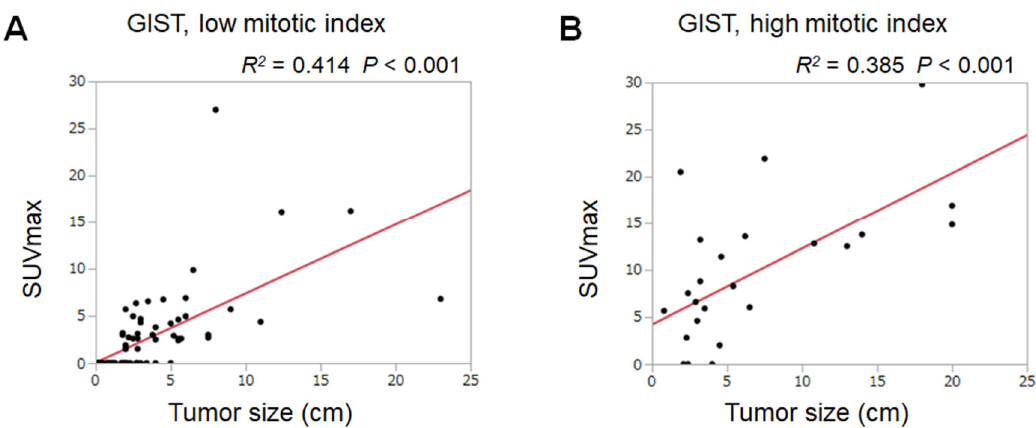
Figure 5. Scatter diagrams and regression lines with respect to tumor sizes and the SUVmax of gastrointestinal stromal tumors with a low mitotic index ( ≤ 5 mitoses / 50 high-power fields, A ) and a high mitotic index ( ≥ 6 mitoses / 50 high-power fields, B ).